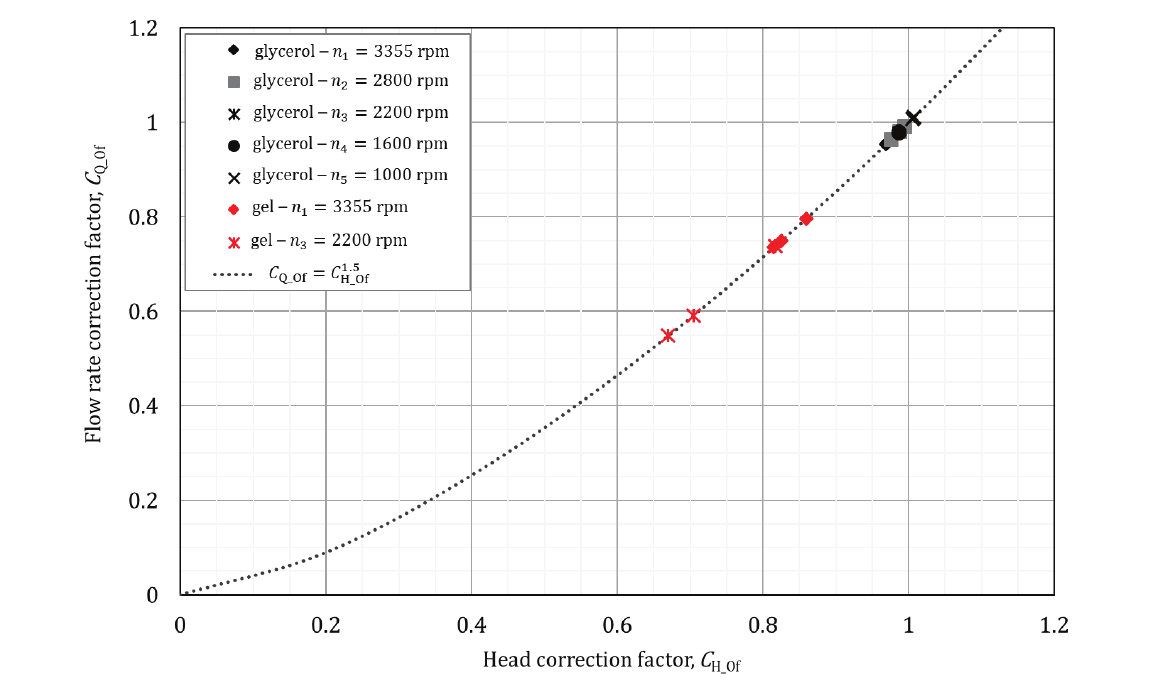
Fig. 4 – Flow rate correction factors versus head correction factors by Ofuchi method at three normalised specific speed values with Wilo-Helix-EXCEL 1602-1/16/E/KS pump